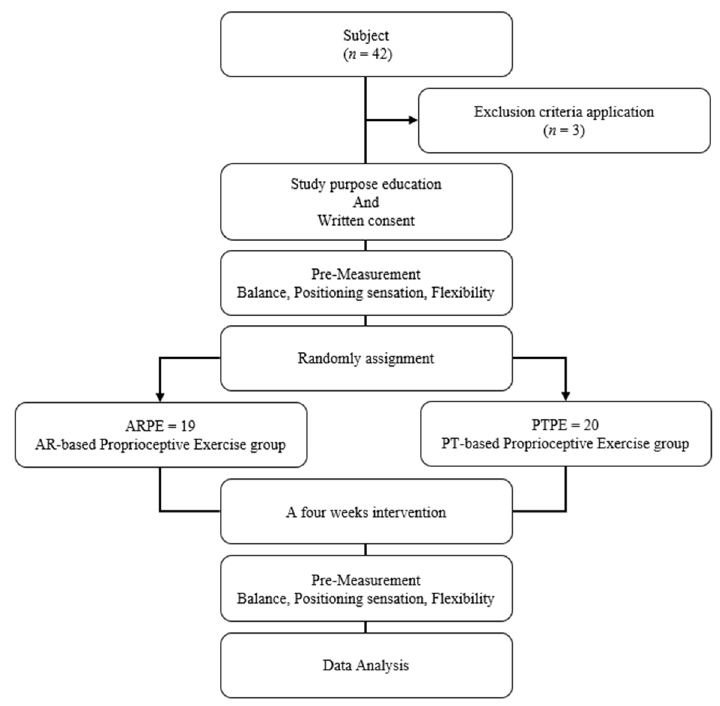
Figure 1. Experiment